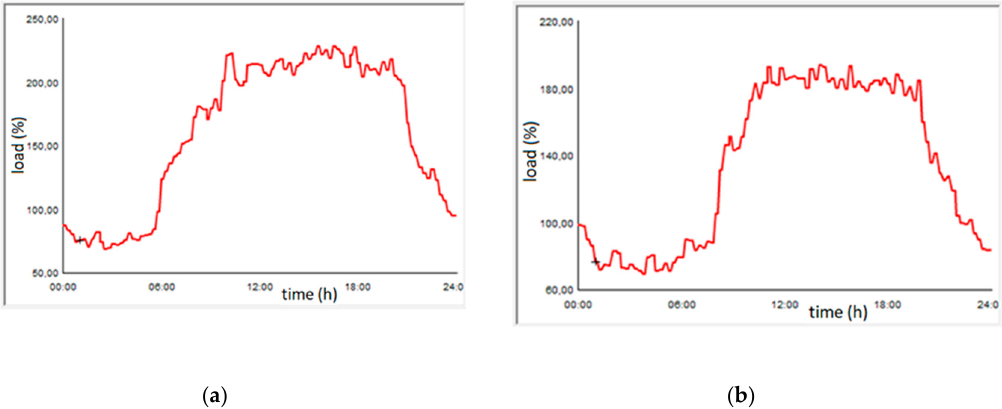
Figure 3. Analyzed load profiles of MV / LV station (left–type ( a ) load profile and right–type ( b ) load profile).